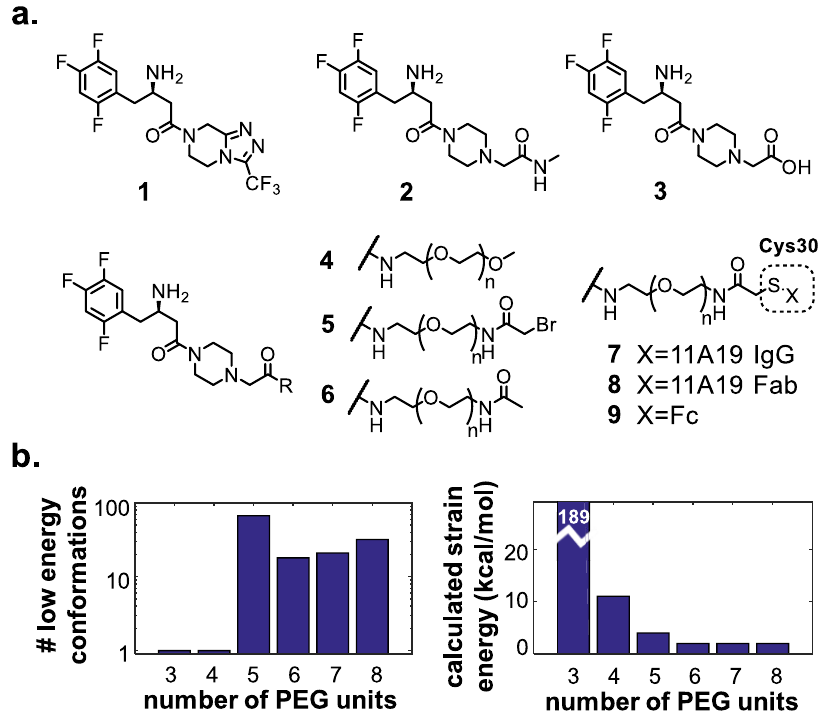
Figure 2. Designed small molecule (SM) analog structures. ( a ) Hybrid molecule design. For 4 – 9 , n indicates number of PEG units. ( b ) Computational modeling and energetic favorableness of 8 with 3–8 PEG units. Left panel: number of low energy conformations in the modeled bound conformation. Right panel: calculated strain energy in lowest energy conformation found, where lower strain energies are expected to be favorable. See Methods for additional